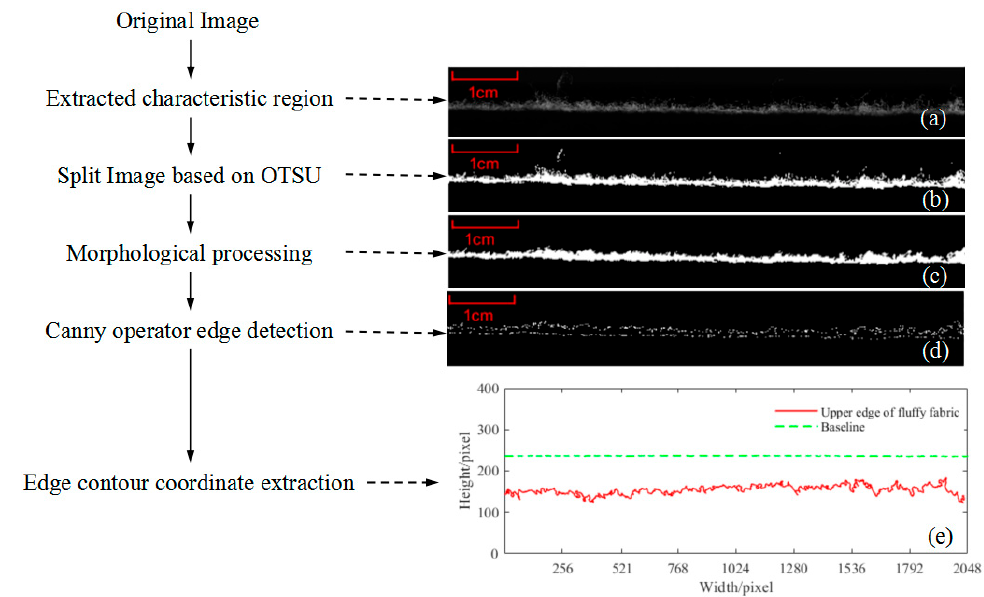
Figure 2. Overview of the proposed method for extracting the fleece edge contour. ( a ) Original image; ( b ) Image segmentation; ( c ) Morphologically processed images; ( d ) Canny operator edge detection image; ( e ) Edge contour image.